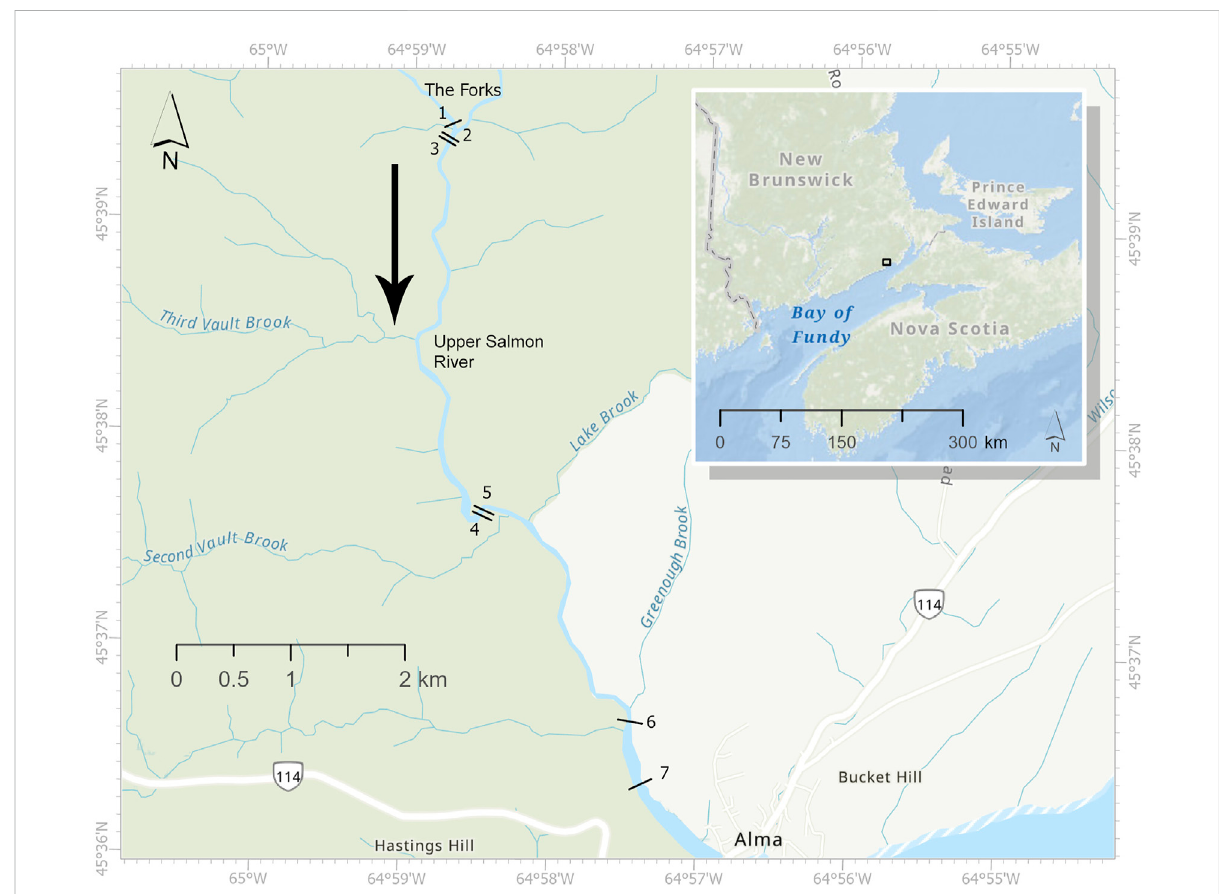
FIGURE 1 Map of the Upper Salmon River within New Brunswick created using the ArcGIS basemap. The black lines represent the approximate locations of seven transects. The inset shows the location of the Upper Salmon River (black box) within New Brunswick. The black arrow indicates the downstream fl ow direction. The Forks, the junction in the Upper Salmon River that leads to the upper limit of salmon distribution, is indicated on the